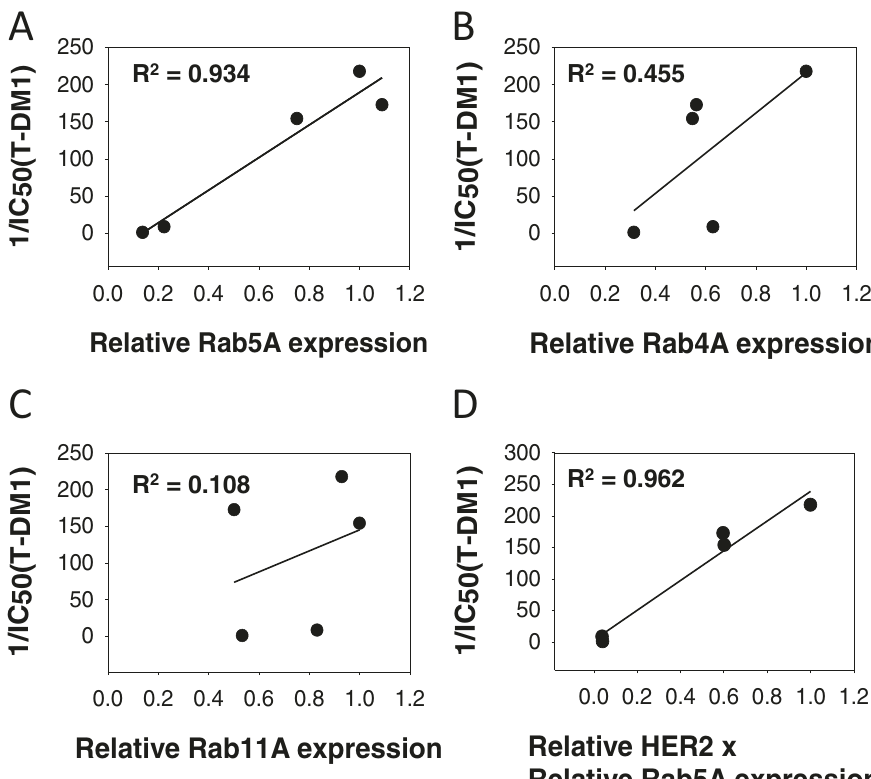
Fig. 3 T-DM1 and RAB GTPase in vitro correlations. Linear regression analysis curves between RAB5A ( A ), RAB4A ( B ), and RAB11A ( C ) protein expression (average of N = 3 as presented in Fig. 2) and T-DM1 sensitivity (1/IC 50 (T-DM1)) (average of N = 3 as presented in Fig. 1 and Table 1) in the fi ve cell lines. D The linear regression curve between HER2 (average of N = 3 as presented in Fig. 2) × RAB5A protein expression and T-DM1 response. Each data point represents one cell line. Source data are provided as a Source Data fi le.